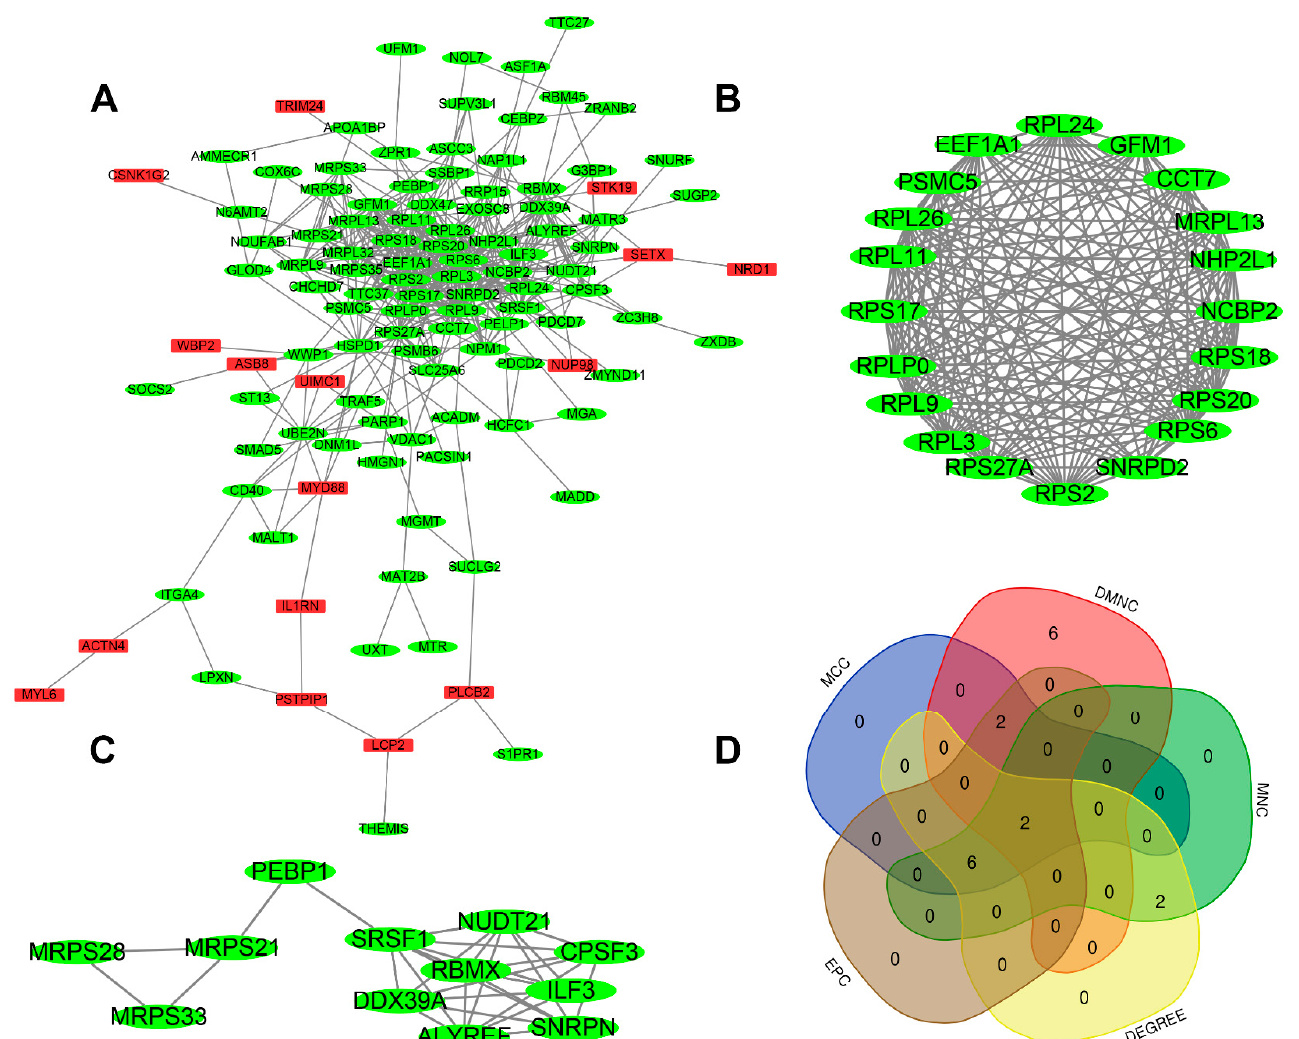
Figure 6. PPI network and hub gene. ( A ) PPI network. Genes in red represent upregulation; genes in green represent downregulation. ( B , C ) The two most significant modules. ( D ) The overlapped hub genes from different algorithms. Table 2. Top ten hub genes obtained by five algorithms of Cytohubba.